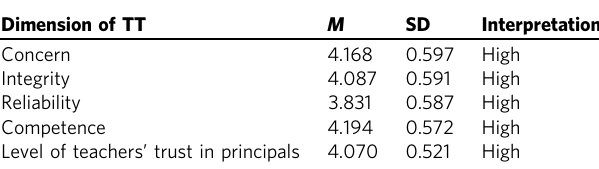
Table 7 The means and standard deviations for TT items.